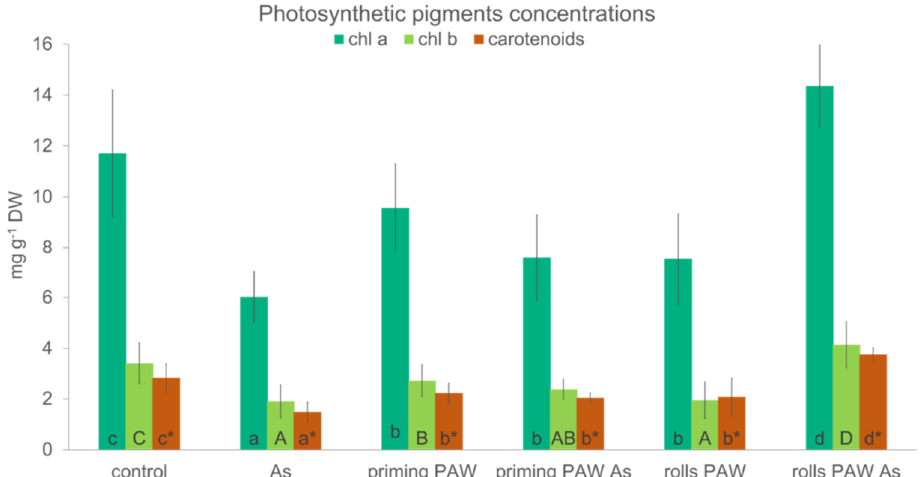
Figure 8. The catalase (CAT) activity of the maize roots and the second leaf (hybrid Bielik) after 10 days of hydroponic cultivation as control or pre-treated with PAW (priming PAW and rolls PAW treatments) without and with As. Values are means of four replicates ± SD. Different letters denote a significant difference between the treatments.